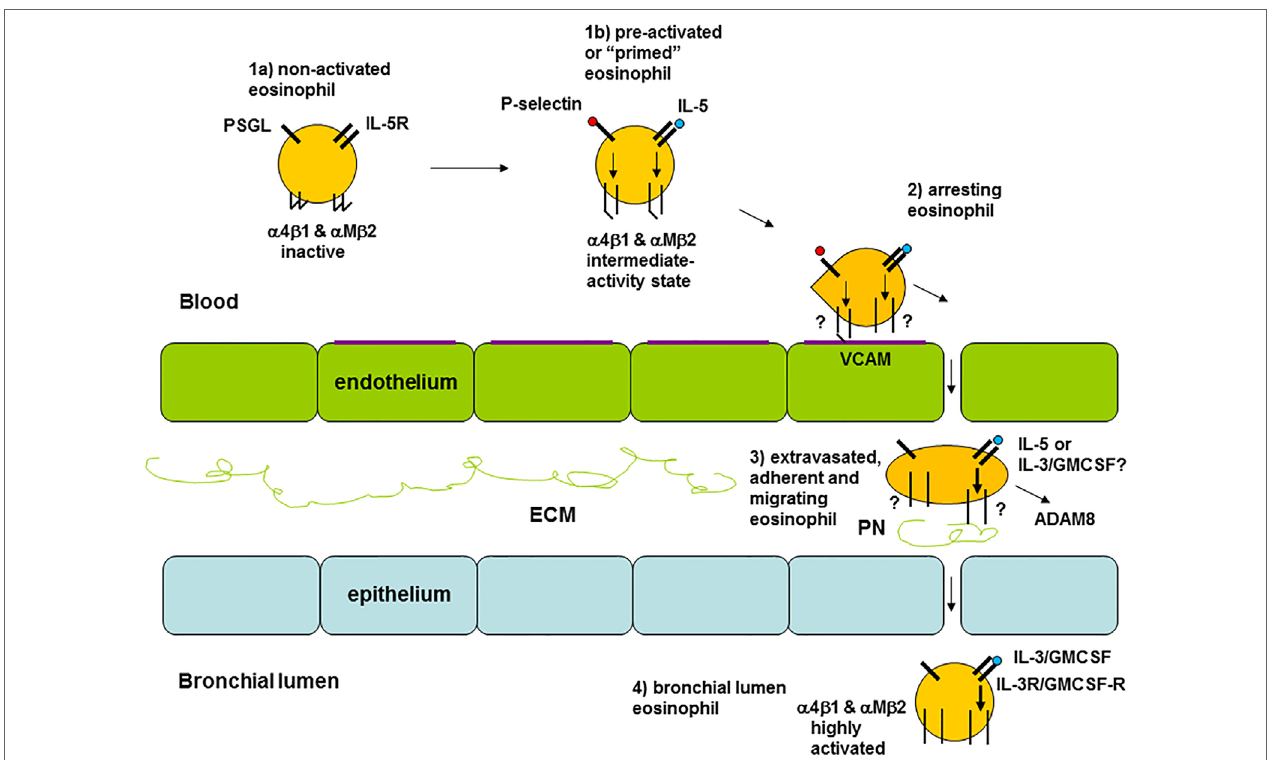
FiGURe 2 | Model of eosinophil activation states in asthma. (1a) Circulating non-activated eosinophil with α 4 β 1 and α M β 2 integrins in the inactive conformation or state, as found in normal subjects, some patients with non-severe asthma, or as observed in severe asthmatic patients likely because of a high degree of extravasation of activated eosinophils. (1b) Pre-activated or “primed,” partly activated, circulating eosinophil with α 4 β 1 and α M β 2 in the intermediate-activity state, as a result of signaling triggered by P-selectin (likely derived from activated platelets, see the main text) and low concentration of interleukin (IL)-5, respectively, as found primarily in some subjects with non-severe asthma. (2) Eosinophil arresting on activated endothelium in asthma with α 4 β 1 and α M β 2 in unknown state, with α 4 β 1 primarily mediating arrest on vascular cell adhesion molecule (VCAM)-1 with a possible minor contribution of α M β 2 . (3) Extravasated, adherent, and migrating tissue eosinophil in asthma with α 4 β 1 and α M β 2 likely in the high-activity state, with high-activity α M β 2 , resulting from cytokine-triggered signaling, mediating interaction with the adhesive and pro-migratory extracellular matrix (ECM) protein periostin, and the eosinophil-releasing disintegrin and metalloproteinase (ADAM) 8 involved in PN degradation and cell migration. (4) Bronchial lumen highly activated eosinophil in asthma with α 4 β 1 and α M β 2 in the high-activity state and with downregulated or no IL-5 receptor, and with high-activity α M β 2 resulting from IL-3 and/or granulocyte monocyte-colony stimulating factor (GM-CSF)-triggered signaling. Modified and extended from Ref. (8) and also based on Ref. (34, 36, 44, 69, 80). Note: this model focuses on the activation states of integrins and on receptors for IL-5 family cytokines. It is not intended to be a full rendition of all possible factors involved in eosinophil recruitment. For instance, glycoproteins and glycans, including endothelial surface selectins and their role in eosinophil rolling, are covered in other reviews within this Research Topic (O’Sullivan JA, Carroll